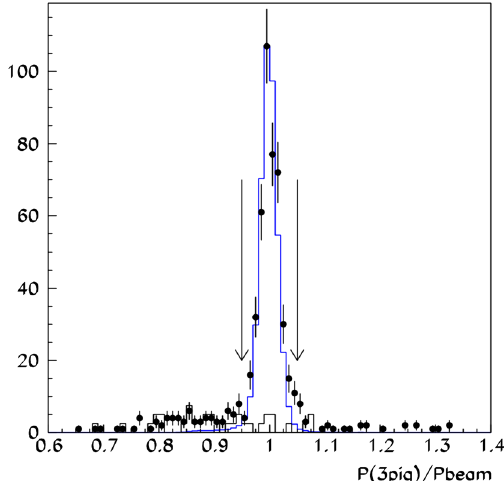
Fig. 3 The ratio of the absolute value of the momentum of the 3 πγ system to the momentum of the beam particle for the data (black circles with errors), main sources of the background (black histogram) and the MC signal (blue histogram). Vertical arrows show the selected signal region